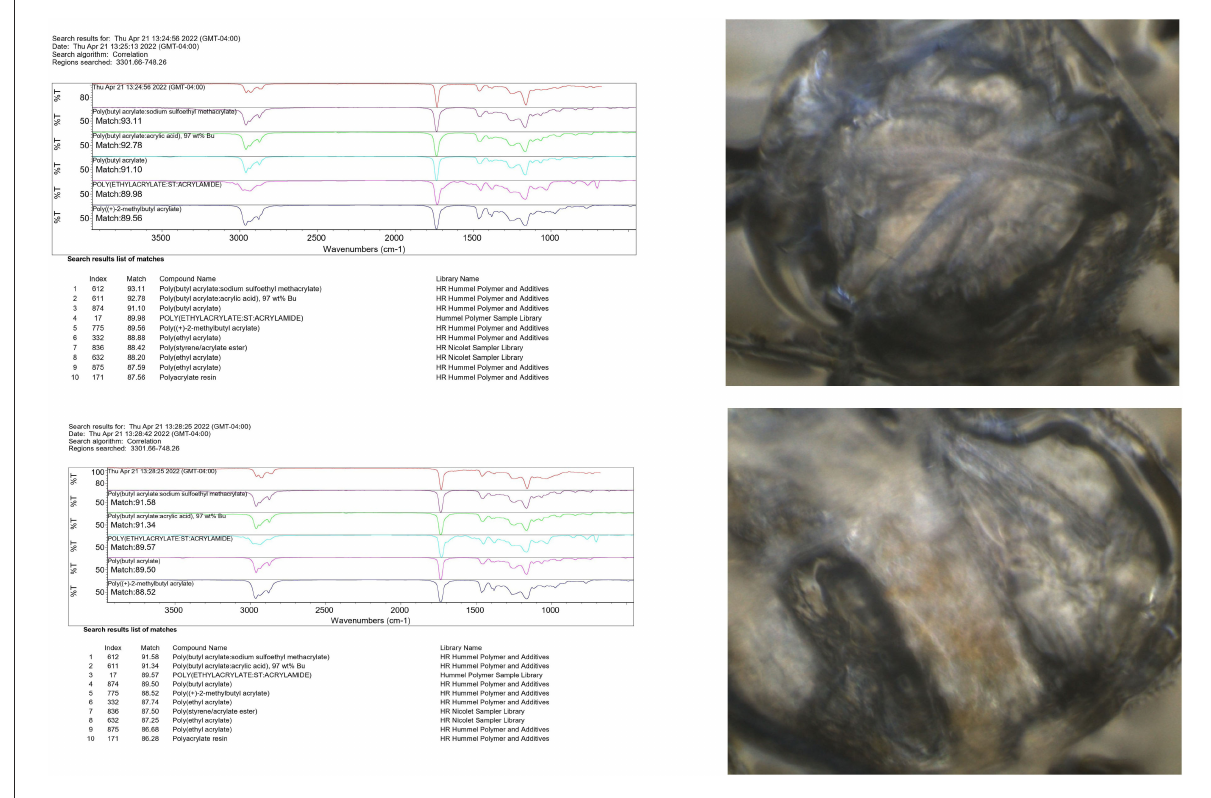
FIGURE6 Micro-FTIR analysis of two suspected plastics from Graham